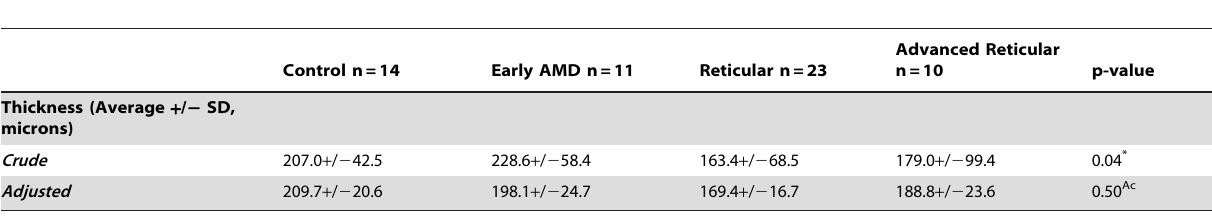
Table 5. Choroidal